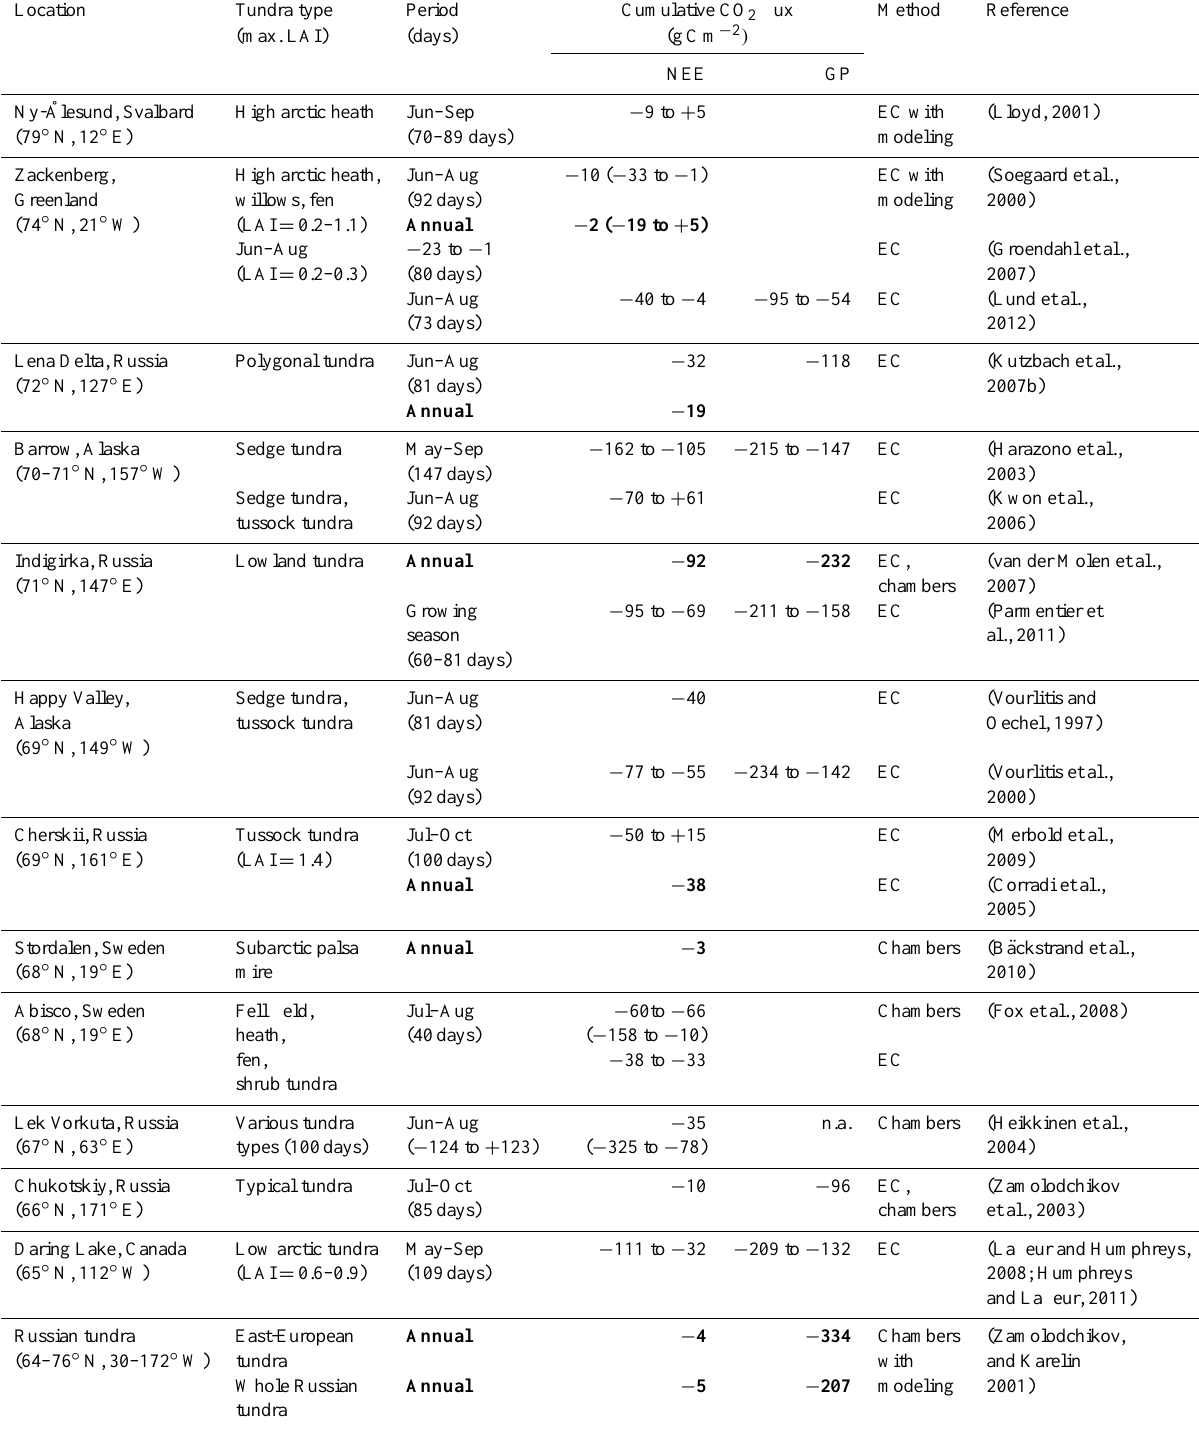
Table 6. Summary of cumulative NEE and GP in different tundra ecosystems based on chamber and eddy covariance (EC) measurements and modeling. From chambers studies only those with area-integrated estimates were included. Ranges indicate the spatio-temporal variability of CO 2